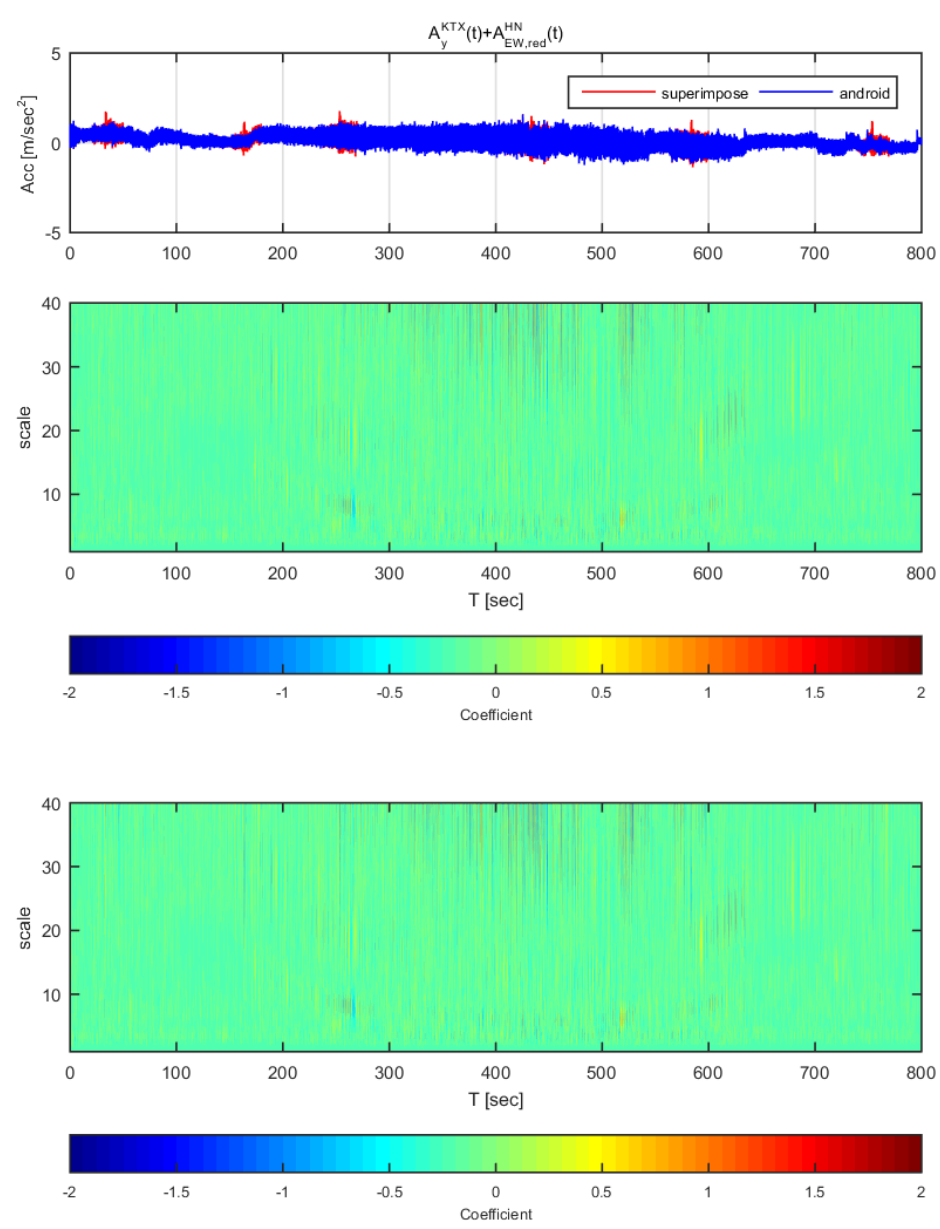
Figure 24. Wavelet transform coefficients for the combination of Korea Train Express (KTX) transverse direction data and Hachinohe earthquake east-west direction data (adjusted to 1 m/s 2 ).